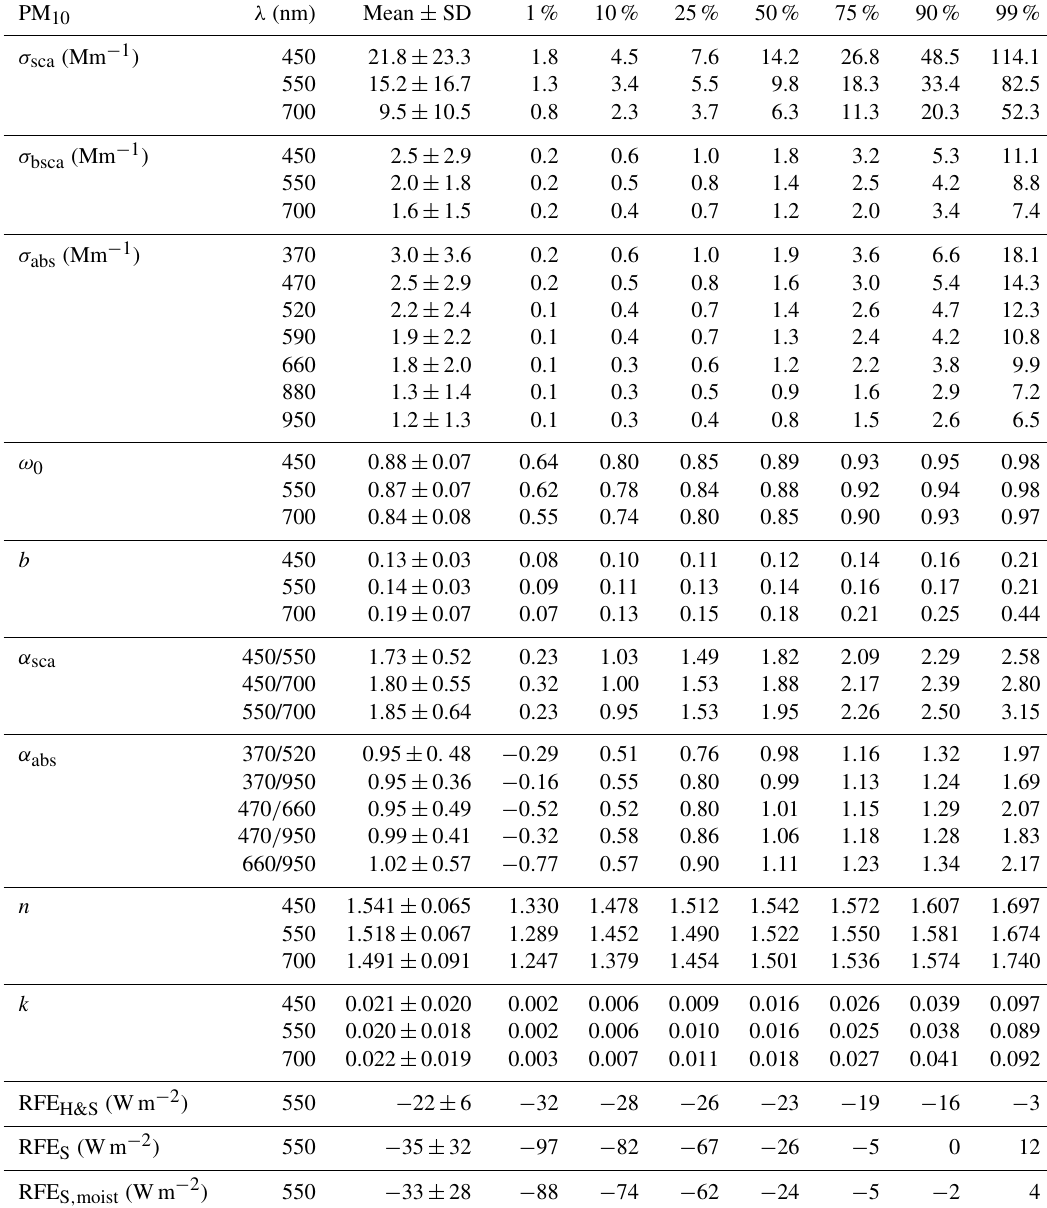
Table 1. Descriptive statistics of the AOPs for the PM 10 particles. The average values were calculated from all valid data. PM